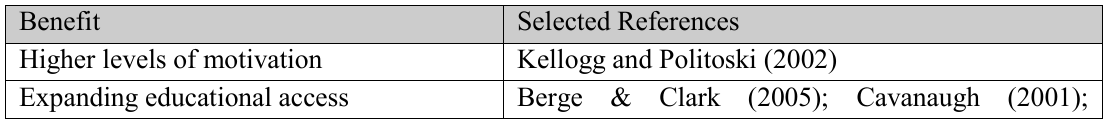
Benefits of Virtual Schooling (Barbour and Reeves, 2009, p. 409)